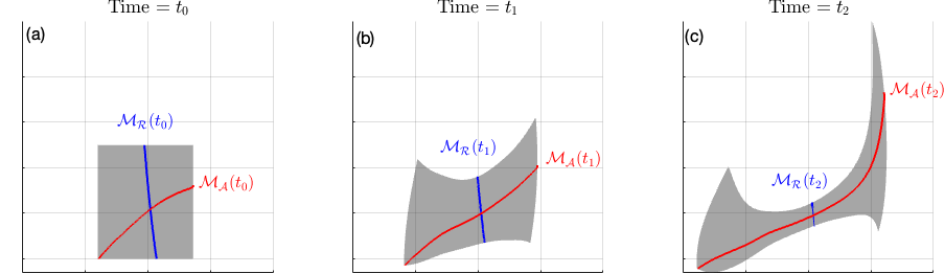
Figure 1. Example of time evolution of fluid particles surrounding hyperbolic LCSs in an incompressible ocean surface current simulation from time t 0 to t 2 . M A is an attracting hyperbolic LCS (unstable manifold), and M R is a repelling hyperbolic LCS (stable